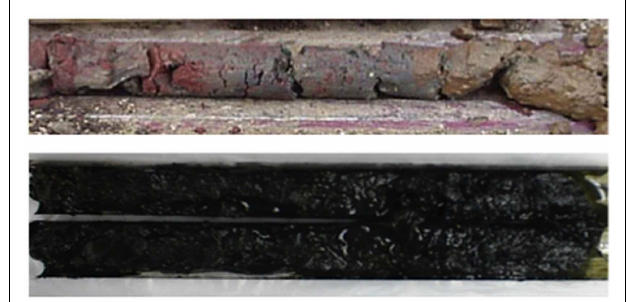
FIGURE 4 | Representative acid pond and upper tidal slough sediment cores from Stege Marsh. Acid pond cores (upper) were comprised primarily of reddish hematite and yellowish-brown iron (oxyhydr)oxide.Tidal slough cores (lower) were almost entirely comprised of well-consolidated black muds.